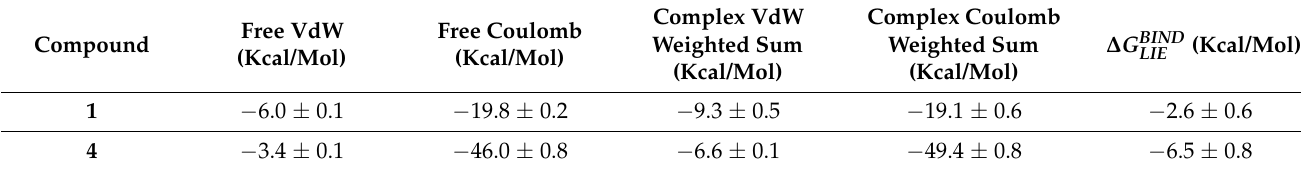
Table 2. Calculation of binding free energies for compounds 1 and 4 using the LIE methodology.